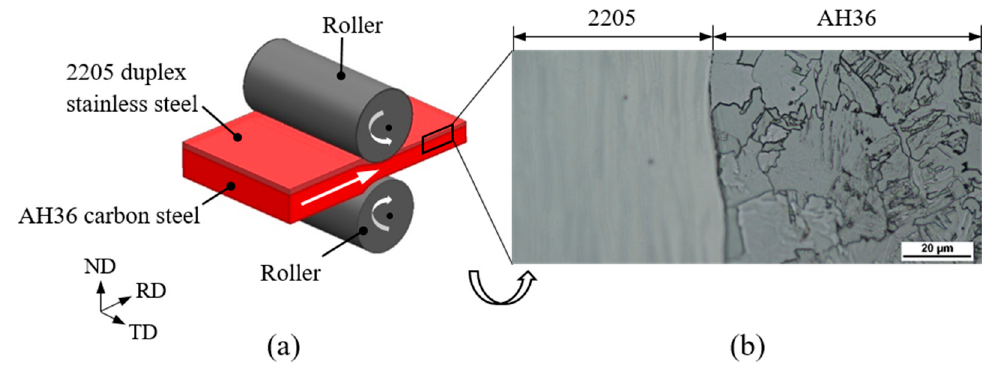
Figure 1. ( a ) Schematic illustration of the hot-rolled 2205/AH36 bimetal composite (BC), and ( b ) the observed metallography of 2205/AH36 BC.